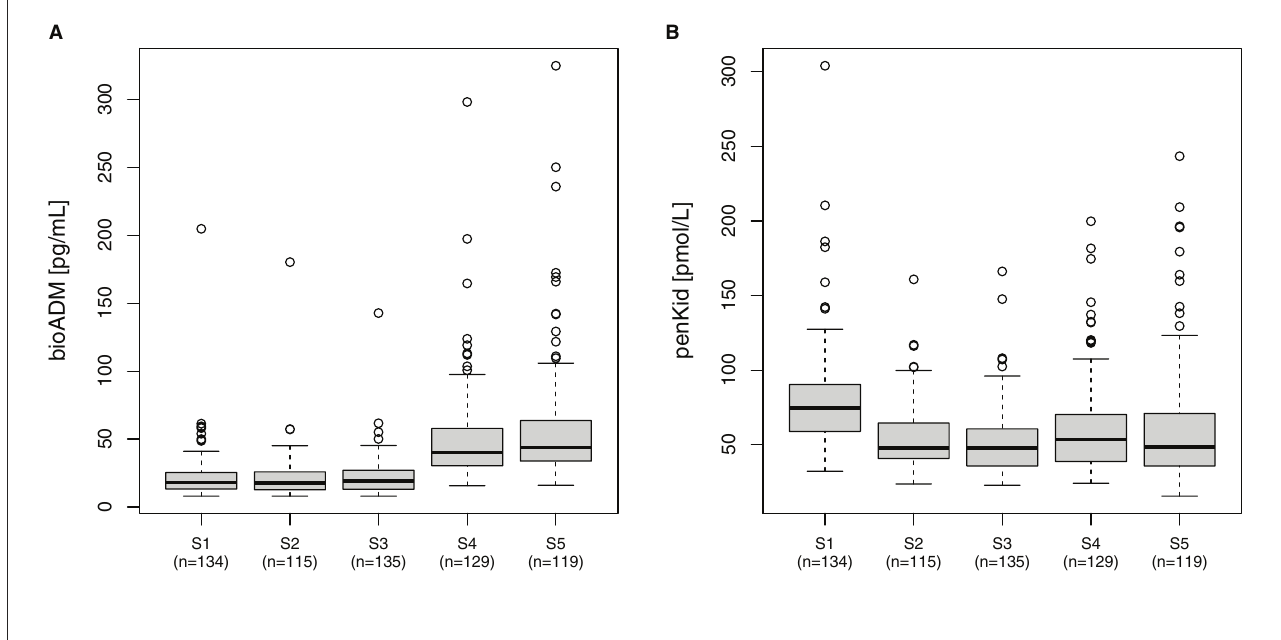
FIGURE1 Perioperative course of (A) bio-ADM and (B) penKid. n, number of patients; S1, prior to surgery; S2, intraoperatively at the end of cardiopulmonary bypass; S3, at ICU-admission; S4, 24h after surgery; and S5, 48h after surgery; bio-ADM, bioactive Adrenomedullin; penKid, proenkephalin A.